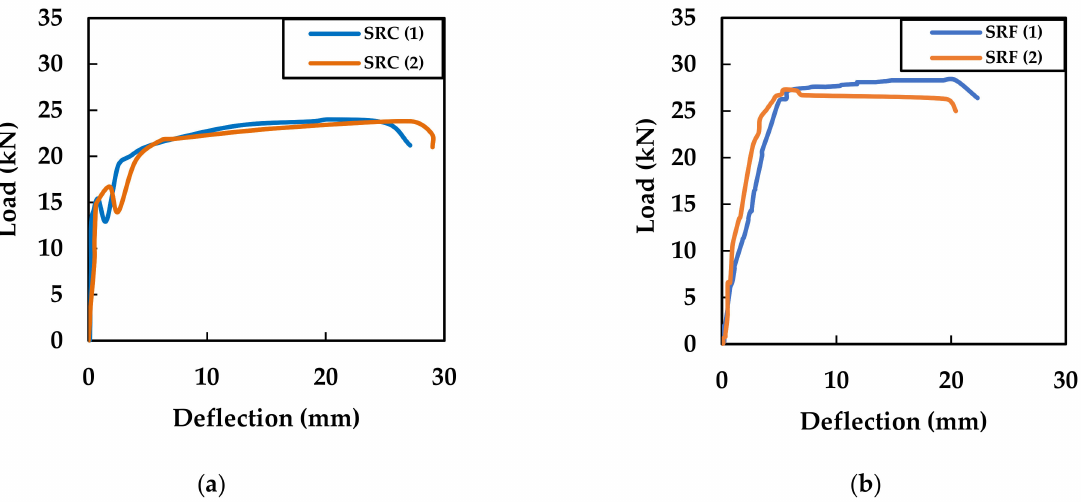
Figure 11. Load–deflection behaviour of ( a ) SRC and ( b )